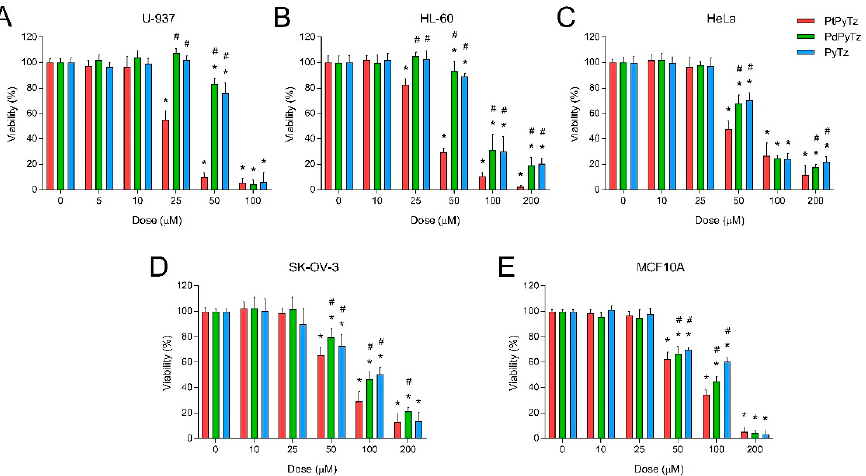
Figure 4. Dose–response curves of chemotherapeutics on cell viability of tumor and non-tumor cell lines. ( A ) U-937, ( B ) HL-60, ( C ) HeLa, ( D ) SK-OV-3 and ( E ) MCF10A cells were treated for 24 h with increasing concentrations (5, 10, 25, 50, 100 and 200 µM, as indicated) of the ligand PyTz, the Pt(II) (PtPyTz) and Pd(II) (PdPyTz) complexes, or the vehicle (DMF, control). Data represent means ± S.D. of six independent experiments and are expressed as a percentage of control values. * p < 0.05 compared to their corresponding control values. # p < 0.05 compared to their corresponding PtPyTz values.